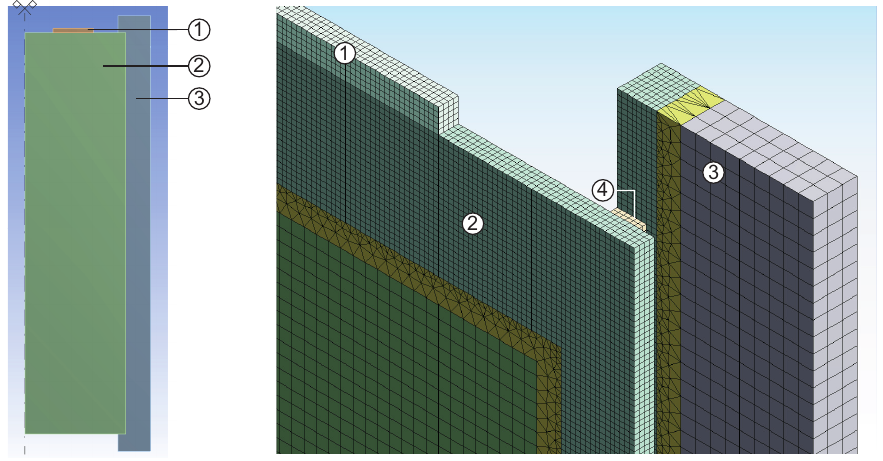
Fig. 6 Geometry and meshing of the numerical